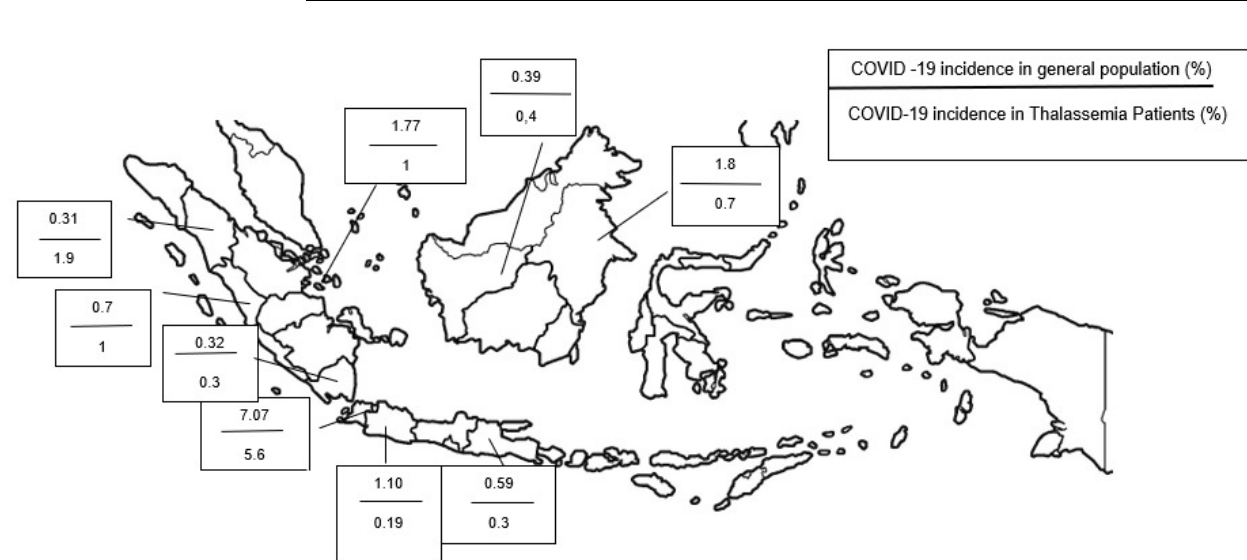
Figure 1. COVID-19 incidence in general population compared to COVID-19 incidence in thalassemia patients. Table 3. Recapitulation of thalassemia in each province and COVID-19 TDT patients [2,4].